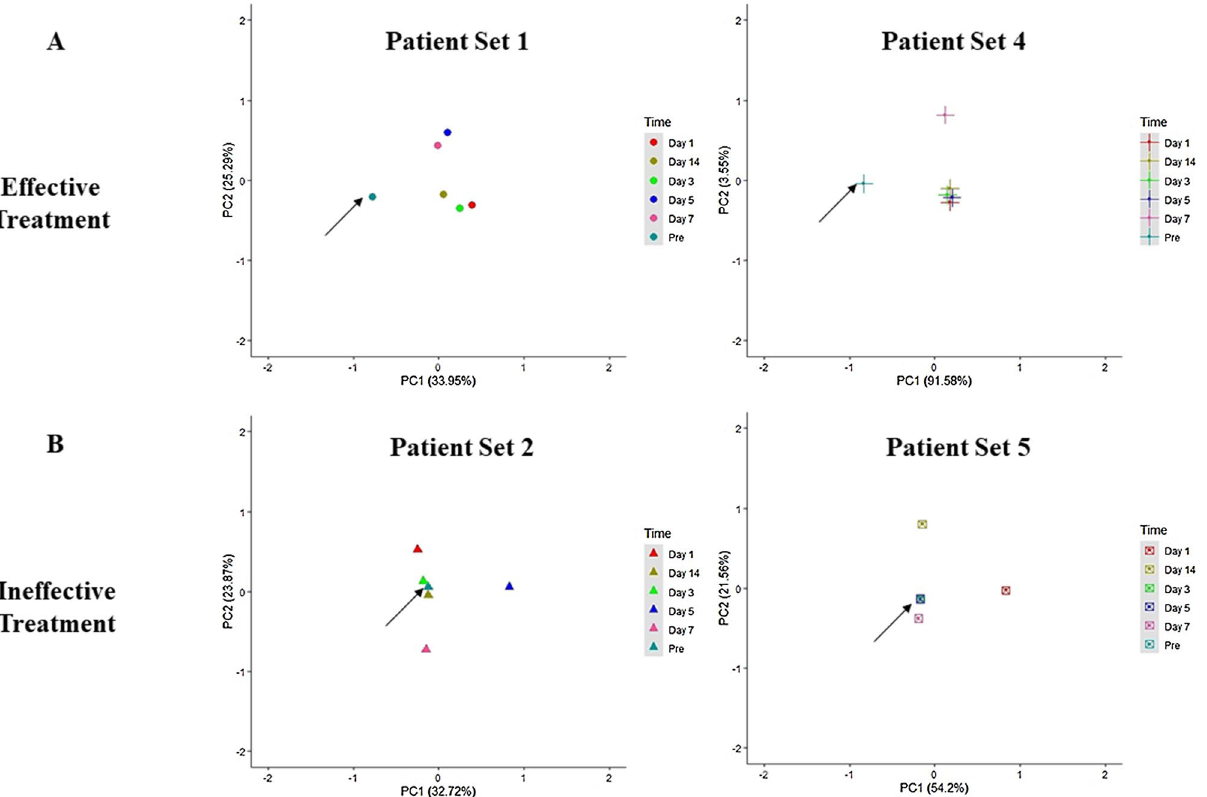
Figure 1. Principle Component Analysis (PCA) plots. The plots show the first and second principal components of the Mtb transcriptional profile from each patient at different time points of treatment (Pretreatment to 14 days’ post-treatment initiation). PCA shows the complete transcriptome in a single point, and each point on the plot represents the Mtb mRNA profile derived from the one patient mask sample at each time point. The top row ( A ) represents PCA plots of patient sets with effective treatment, and the bottom row ( B ) represents PCA plots of patient sets with ineffective treatment. The arrow marks the pretreatment point on the PCA